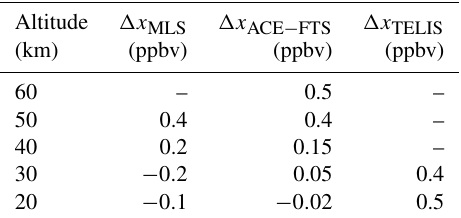
Figure 8. Comparison between SMILES and ACE-FTS profiles from 16 October 2009 to 17 April 2010. (a) The mean HCl VMR values (solid lines) and 1 σ (shaded areas) for SMILES and ACE- FTS. The blue and green lines are the SMILES and ACE-FTS HCl profiles, respectively. (b) The absolute difference between the SMILES and ACE-FTS profiles calculated using Eq. (3). (c) The relative difference between the SMILES and ACE-FTS profiles cal- culated using Eq. (4). Table 4. Summary of the HCl comparison study between SMILES and the other